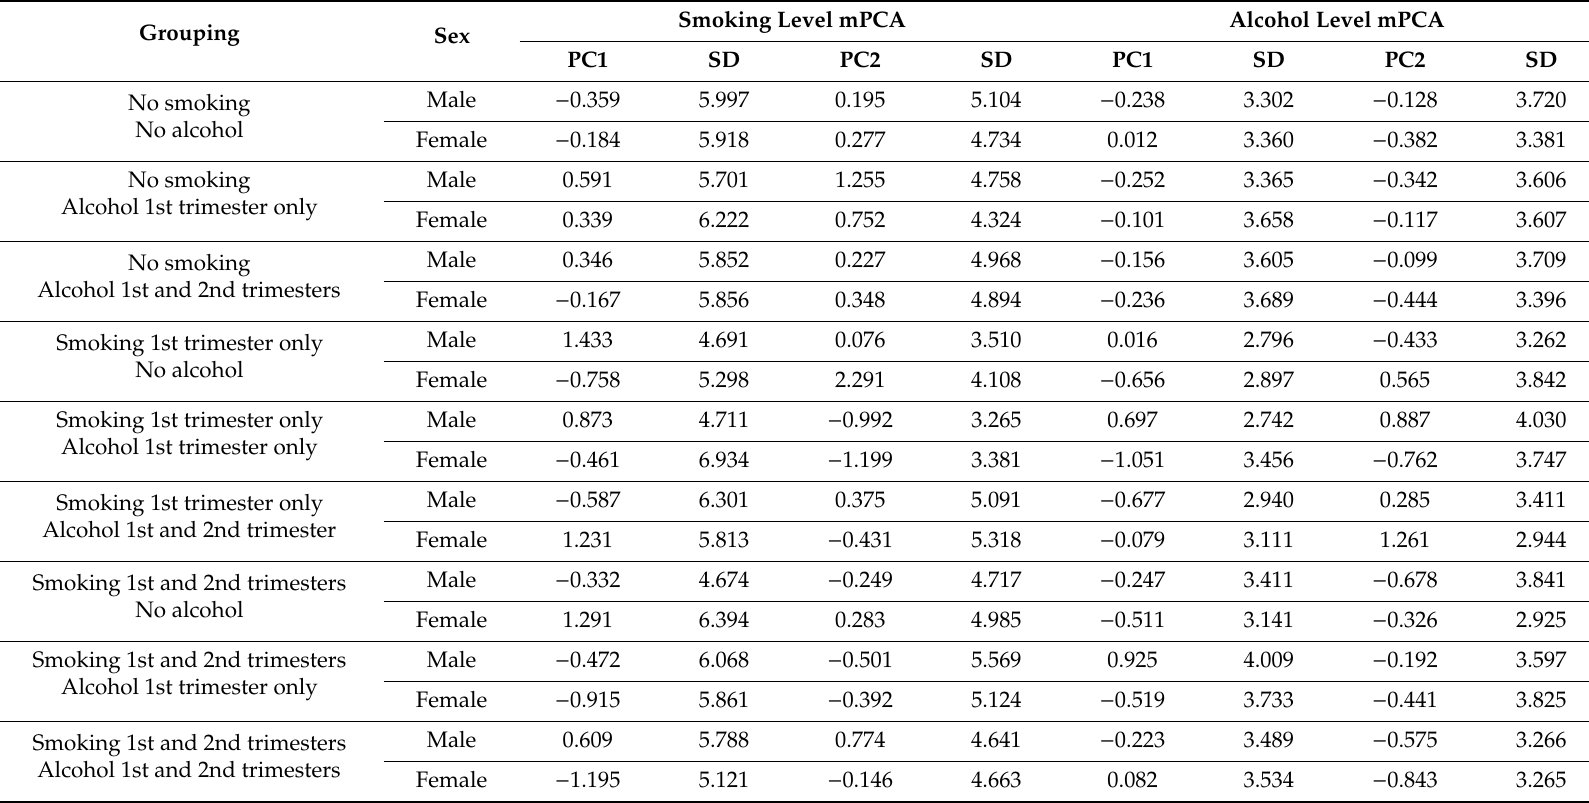
Table 4. Mean standardised component score and standard deviation for each